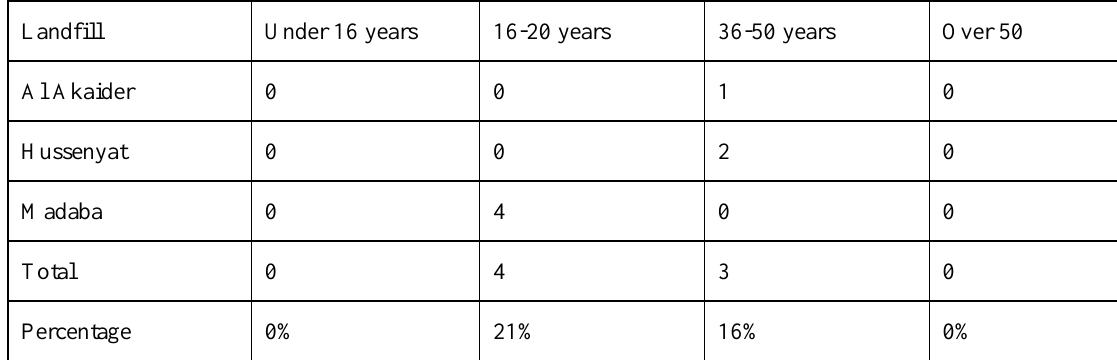
Table 2. Ages of waste pickers